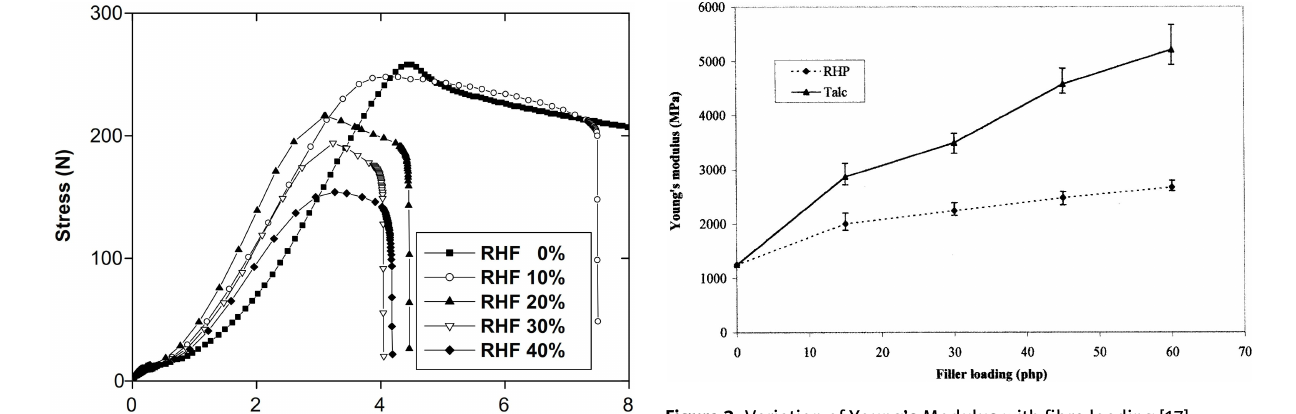
of tensile test for different compositions of RH is shown in Figure 1 accompanied by stress strain curve in Figure 2.